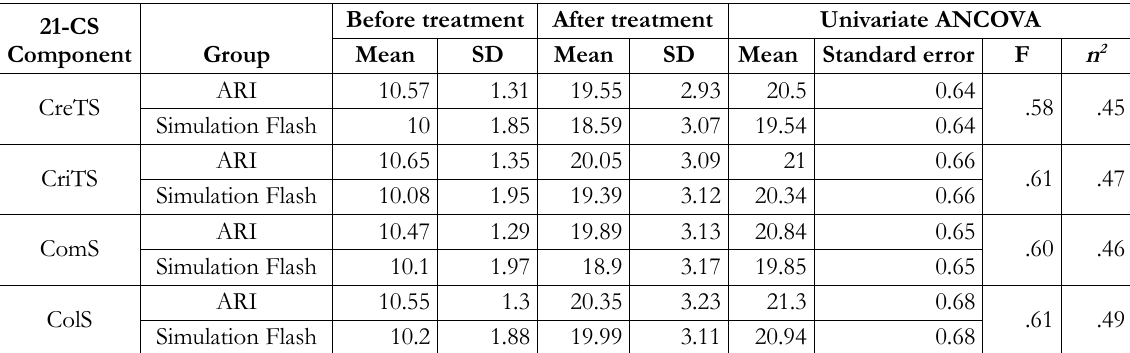
Table 2. Descriptive statistics of students’ pre-test and post-test scores on the ARI based on MPIL with ANCOVA